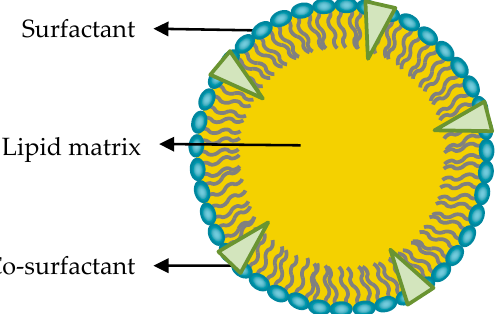
Figure 1. Proposed model of solid lipid nanoparticles structure. Schematic representation of solid lipid nanoparticle (SLN) structure, showing the surfactant, cosurfactant, and the solid lipid matrix.